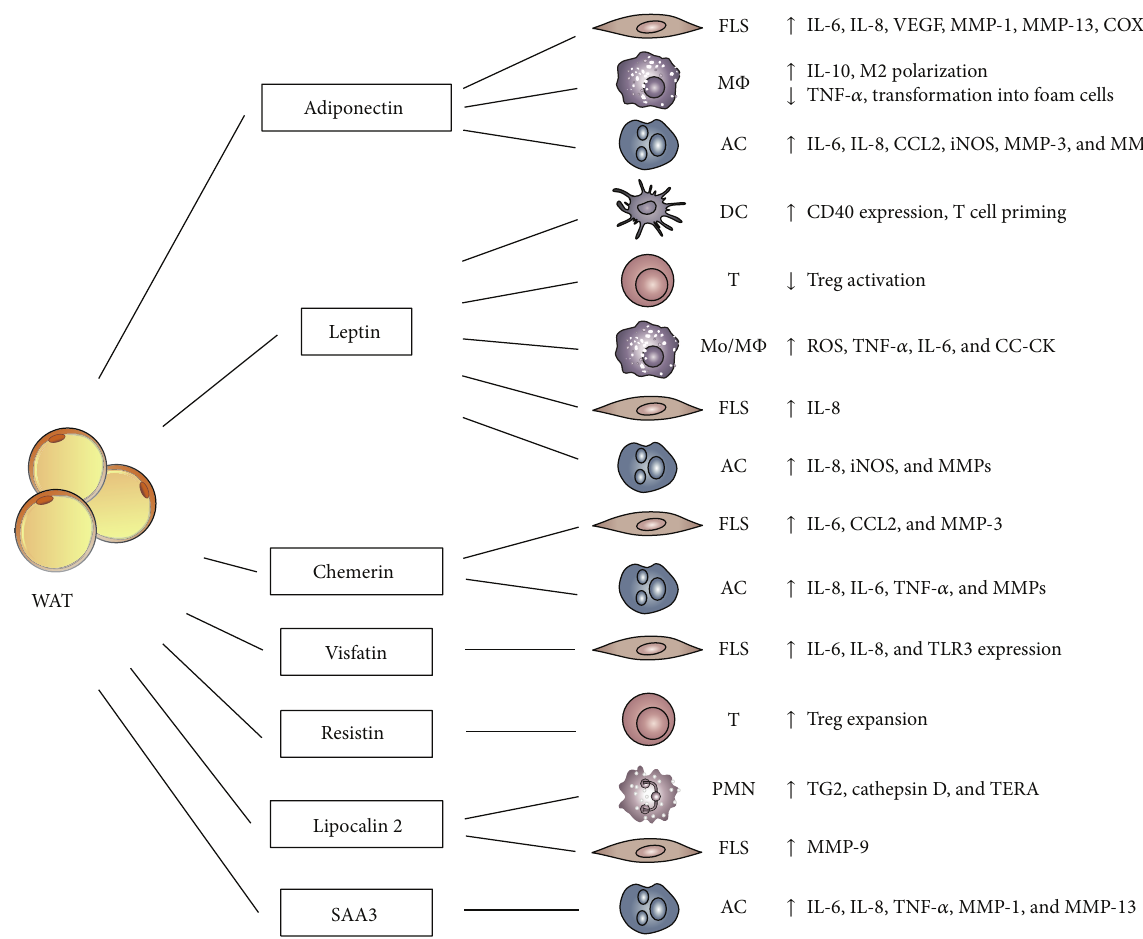
Figure 1: Role of adipokines on RA effector cells. The role of different adipokines on RA target cells is illustrated in the figure. WAT: white adipose tissue, SAA3: serum amyloid A3, FLS: fibroblast-like synoviocytes, AC: articular chondrocytes, PMN: neutrophils, MMP: metalloprotease, COX-2: cyclooxygenase 2, ROS: reactive oxygen species, iNOS: inducible nitric oxide synthase, CC-CK: CC-chemokines, TG2: transglutaminase 2, and TERA: transitional endoplasmic reticulum